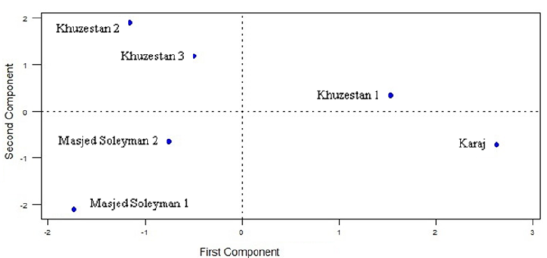
Fig. 3. Genotypes distribution biplot resulted in two first components of